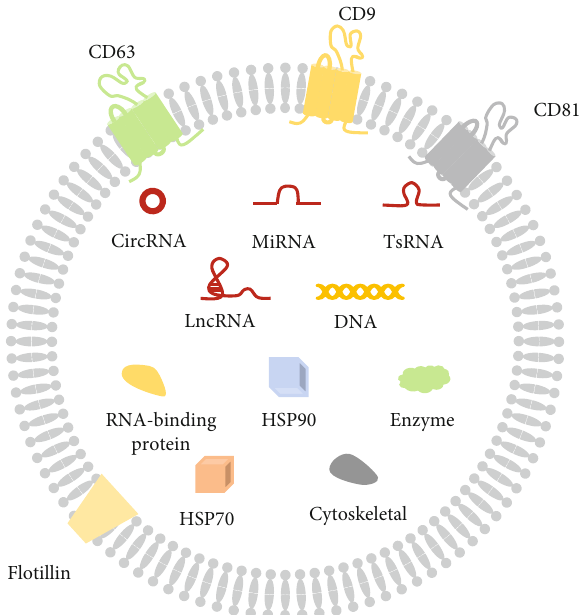
Figure 2: The structure and contents of exosomes. Exosome is a kind of vesicle surrounded by a lipid bilayer in the periphery, and it contains nucleic acid, lipid, protein, and other substances. HSP70: heat shock protein 70; HSP90: heat shock protein 90; tsRNA: tRNA-derived small